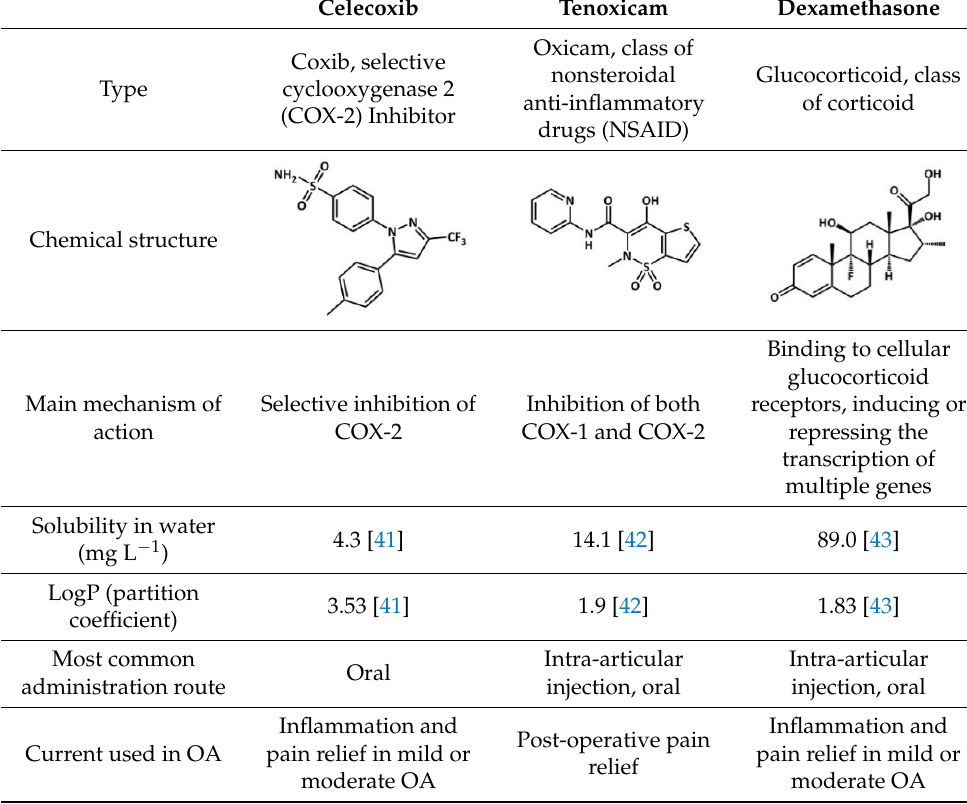
Table 1. Summary of celecoxib (CLX), tenoxicam (TNX) and dexamethasone (DEX) properties related to the treatment of osteoarthritis (OA).